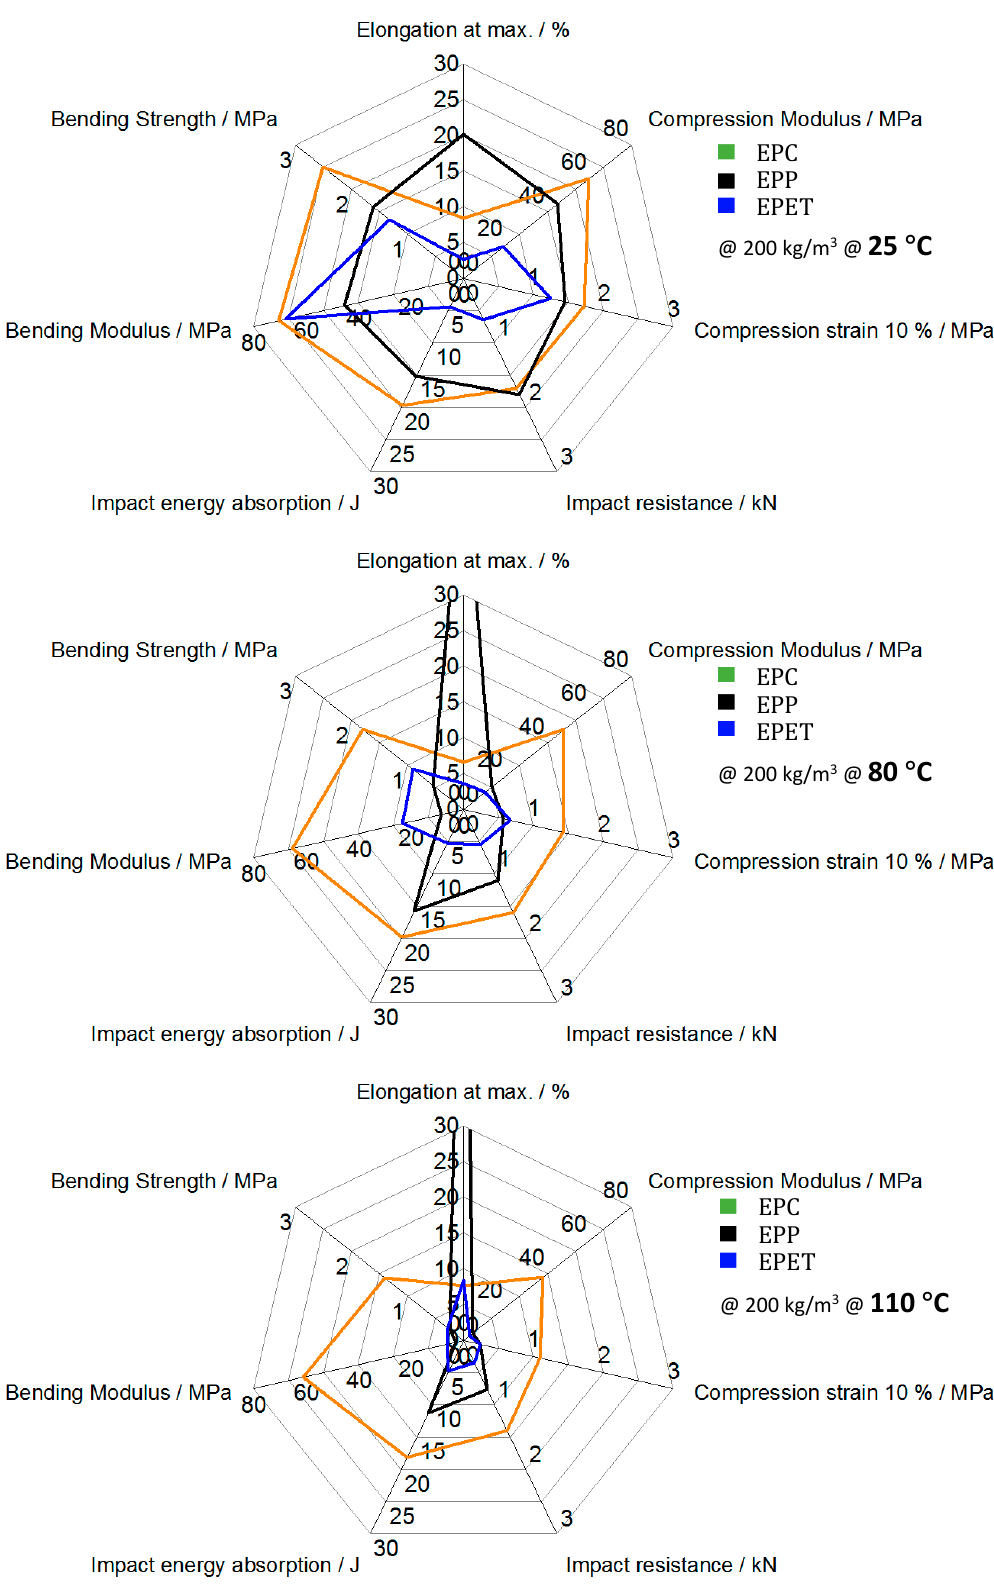
Figure 15. Graphical conclusion of temperature-dependent mechanics of EPC, EPP, and EPET.